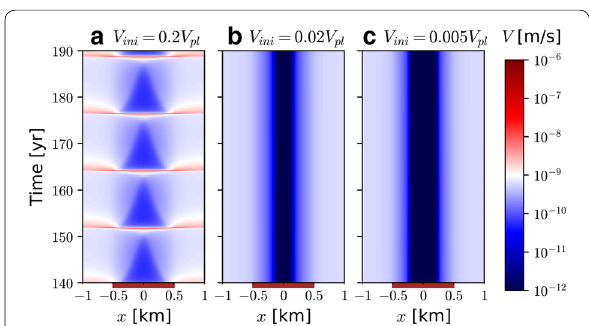
Fig. 8 Spatiotemporal distribution of V in viscoelastic cases with different V ini values and with R EL c / R = 1 and t c / t load = 1.5 . a V ini = 0.2 V pl . The system produces repeating AT, similar to the case with small initial perturbation (Fig. 6). b V ini = 0.02 V pl . The rate-weakening patch is stuck. c V ini = 0.005 V pl . The rate-weakening patch is stuck similar to b , but the stuck part of the patch is